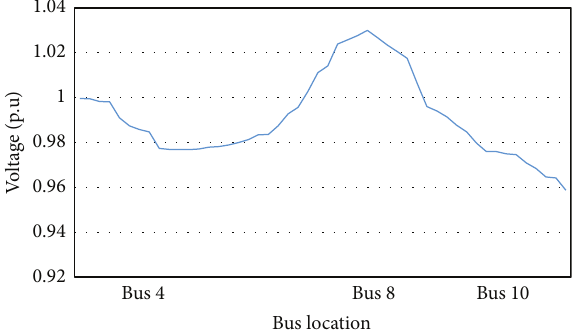
Figure 4: Voltage profile for utility sector without PVGS.